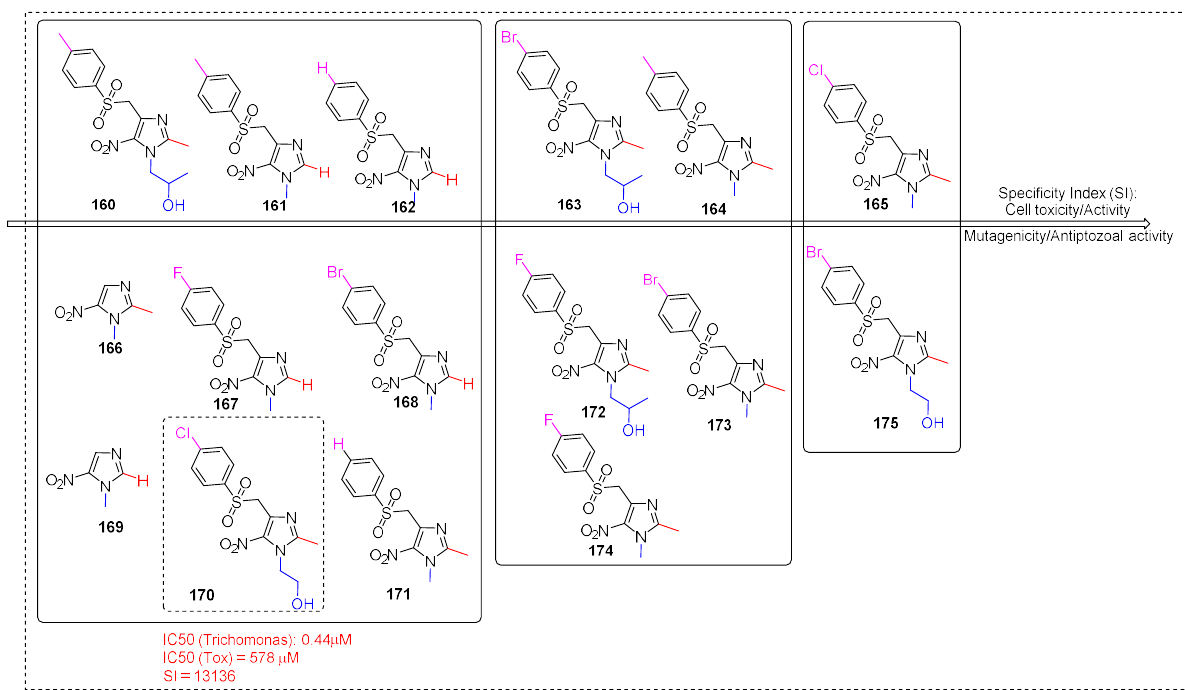
Figure 31. Cytotoxic activity and the antitrichomonas activity of 5-nitroimidazole derivatives. Buschini et al. analyzed the genotoxicity of Nifurtimox 176, Benznidazole 2 , and Metronidazole 7 (Figure 32) [200].